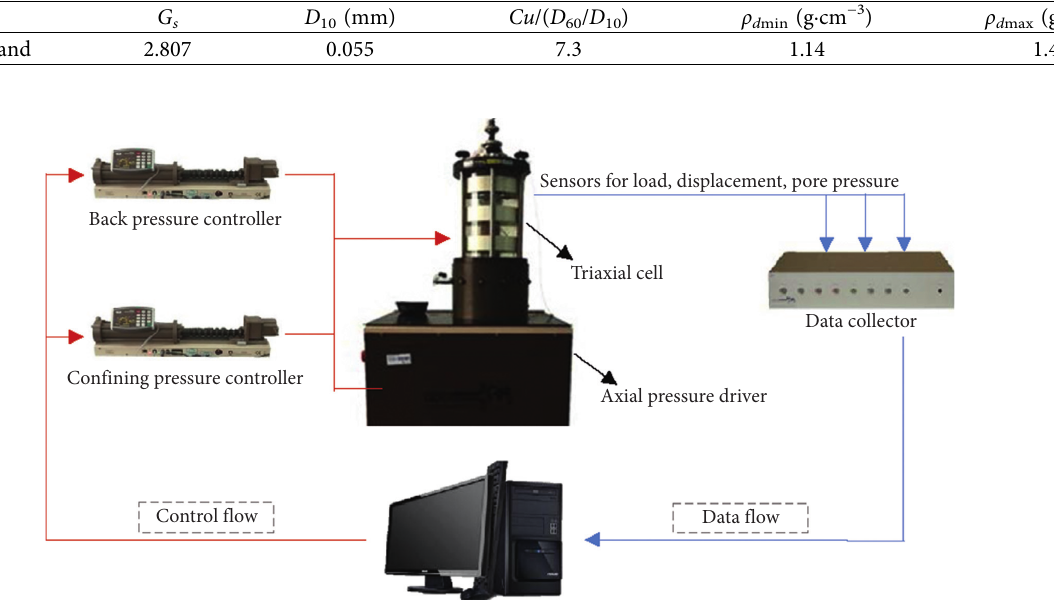
Figure 2: Grain size distribution curve of sand samples tested. Table 1: Physical properties of test calcareous sand.